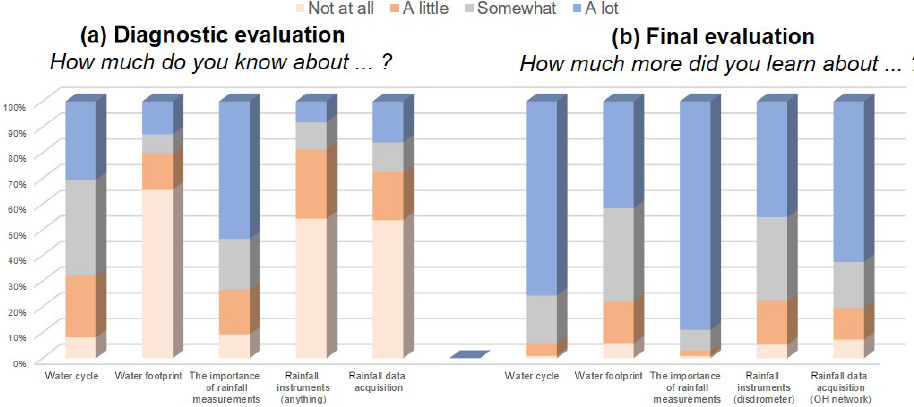
Figure 10. Compilation of answers to questions related to water concepts before (a) and after (b) the workshop.